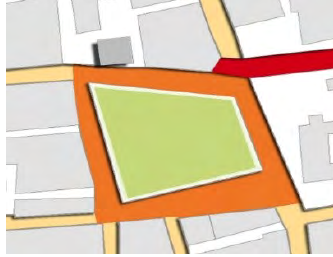
Figure 20. (Rashid public park)